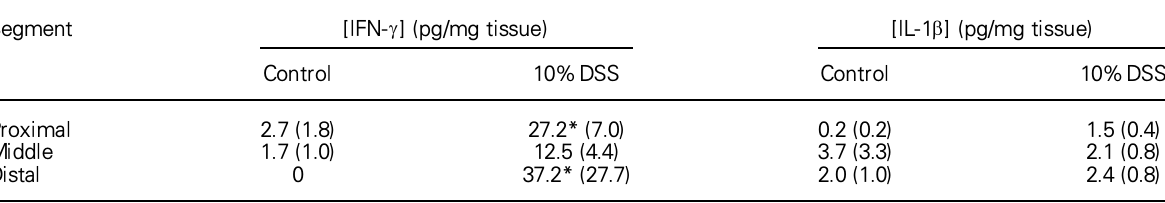
Table 3. Experimentally induced colitis by 10% DSS administration to BALB/c mice. IFN- g and IL-1 b levels in proximal, middle and distal colon segments of control ( n = 5) and 10% DSS treated mice ( n = 7)